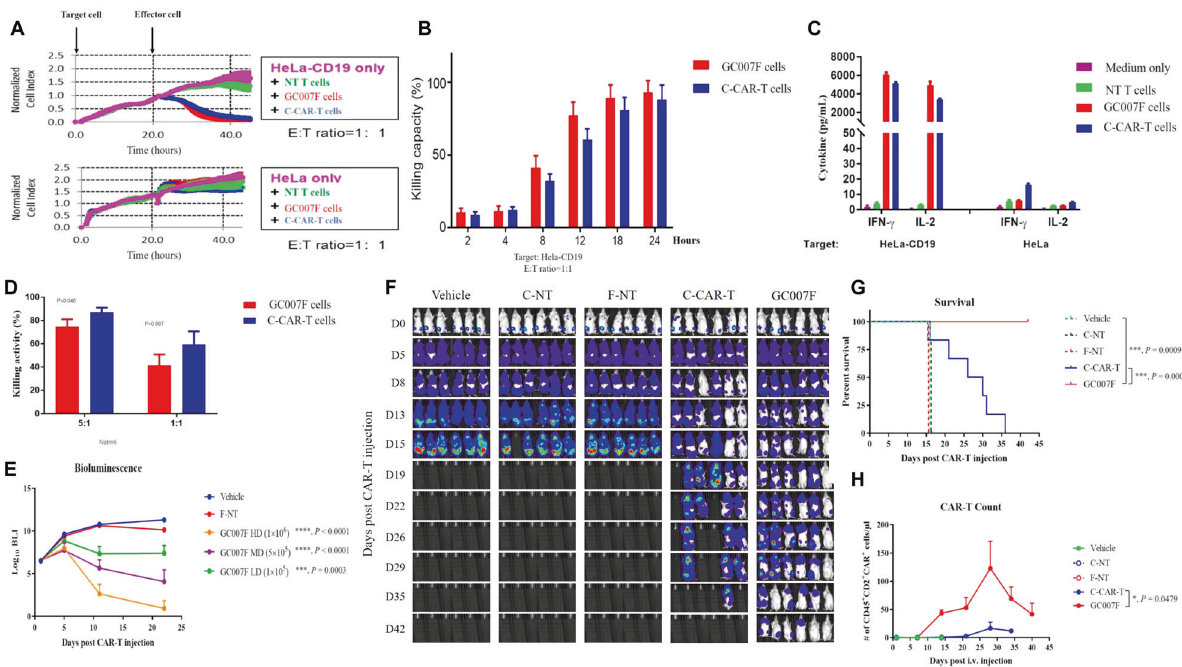
Fig. 3 In vivo and in vitro tumoricidal effects of GC007F cells. A The speci fi c killing of HeLa-CD19 cells was detected by RTCA assays. B Growth curves for HeLa-CD19 cells in the GC007F cell- and C-CAR-T cell-treated groups. C The concentrations of IFN- γ and IL-2 in the culture supernatant were quanti fi ed using ELISA. D CD19 + Nalm6-luciferase cells were cocultured with CAR-T cells at different ratios, and the cell- killing ef fi cacy (%) was determined by measuring luciferase activity. E The tumor burdens in mice treated with different doses of GC007F cells were measured using IVIS. HD: high dose, MD: medium dose, LD: low dose. F Bioluminescence imaging of the tumor burden at the indicated time points after CAR-T cell infusion (5 × 10 5 cells). G Survival of tumor-bearing mice treated with GC007F cells, C-CAR-T cells, or the corresponding nontransduced (NT) controls (C-NT or F-NT cells). H The expansion of infused CD45 + CD2 + CAR + T cells in the peripheral blood was quantitated using fl ow cytometry. Data are representative of two or more independent experiments. All data represent the mean ± SEM ( n ≥ 6 per group) and were analyzed using two-way ANOVA ( E , versus vehicle), the Mantel-Cox test ( G ), or a paired t test ( H